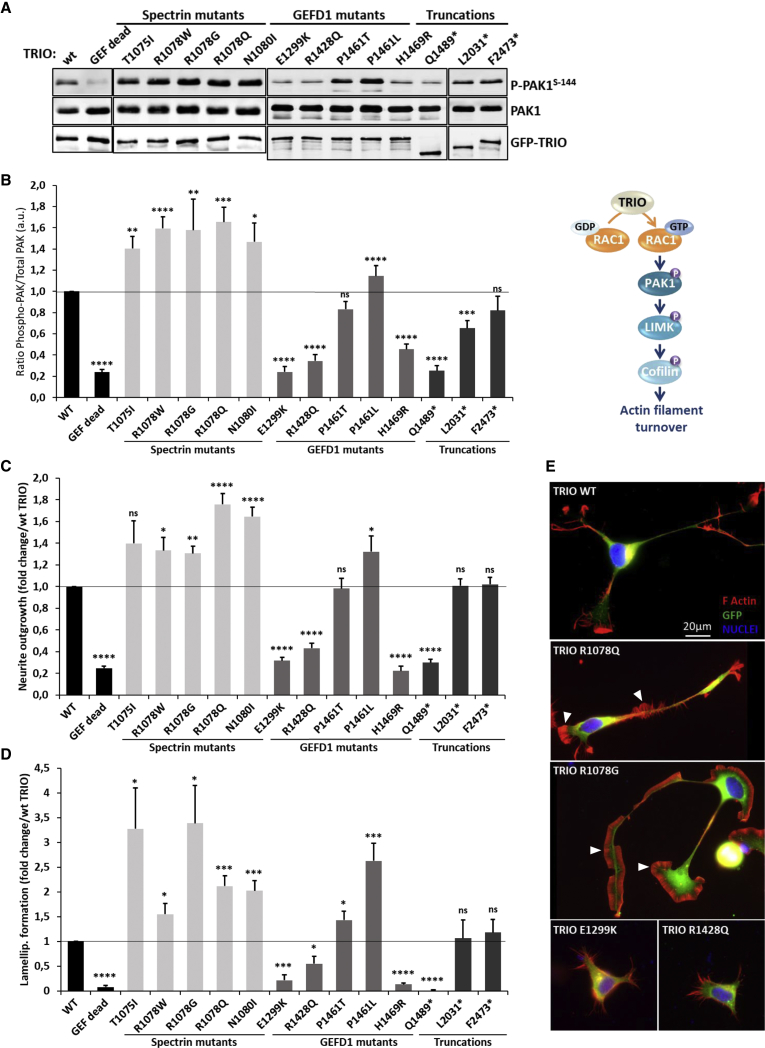
The Spectrin Mutants of TRIO Enhance RAC1 Signaling, Neurite Outgrowth, and Lamellipodia Formation in N1E-115 Cells, Whereas the GEFD1 Mutants Are Mostly Impaired in These Processes(A) Immunoblot analysis of HEK293T cell lysates transfected with the indicated GFP-TRIO variants and detected with an anti-GFP antibody (lower panel). PAK1 phosphorylation amounts are detected with a phospho-Ser144 PAK1 antibody (upper panel) and compared to total PAK1 amounts detected with a PAK1 antibody (middle panel).(B) Quantification of the ratio of phospho-PAK1 amounts over total PAK1 expression. PAK1 phosphorylation is used as a readout for the activation of the RAC1 signaling cascade. Data are presented as the mean ± SEM of at least five independent experiments.(C) Quantification of the neurite outgrowth induced by WT or mutant TRIO. Neurite outgrowth is monitored on the basis of the number of cells harboring an extension of at least twice the length of the soma. Data are presented as n-fold change over WT TRIO, which was arbitrarily set to 1. Data are presented as the mean ± SEM of at least five independent experiments.(D) Quantification of lamellipodia formation induced by WT or mutant TRIO. Data are presented as n-fold change over WT TRIO, which was arbitrarily set to 1. Data are presented as the mean ± SEM of at least five independent experiments.Statistical analysis in (B), (C), and (D) were made by one-way ANOVA followed by Dunnett’s test. Asterisks indicate datasets significantly different from WT (∗p < 0.05, ∗∗p < 0.01, ∗∗∗p < 0.001, and ∗∗∗∗p < 0.0001).(E) Micrographs of N1E-115 cells transfected with the indicated GFP-TRIO variants (green); rhodamine-phalloidin and Hoechst stained the actin (red) and nuclei (blue), respectively. Representative images for each variant type are presented. White arrowheads point to lamellipodia. Scale bar: 20 μm.